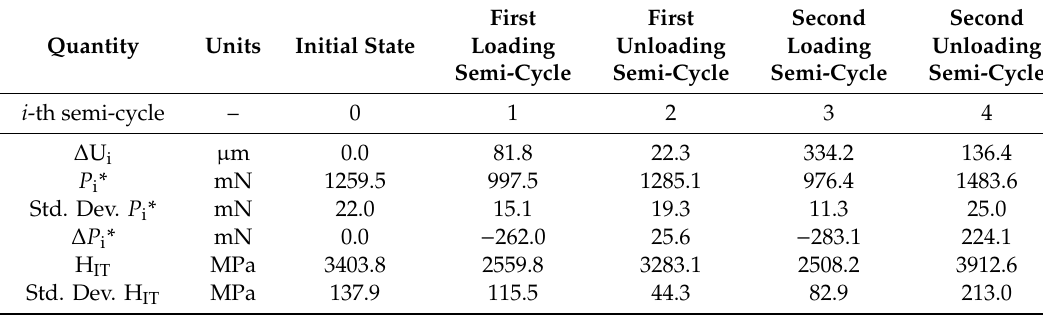
Table 1. Experimental results obtained using the Micro Combi Tester and complemented by statistical